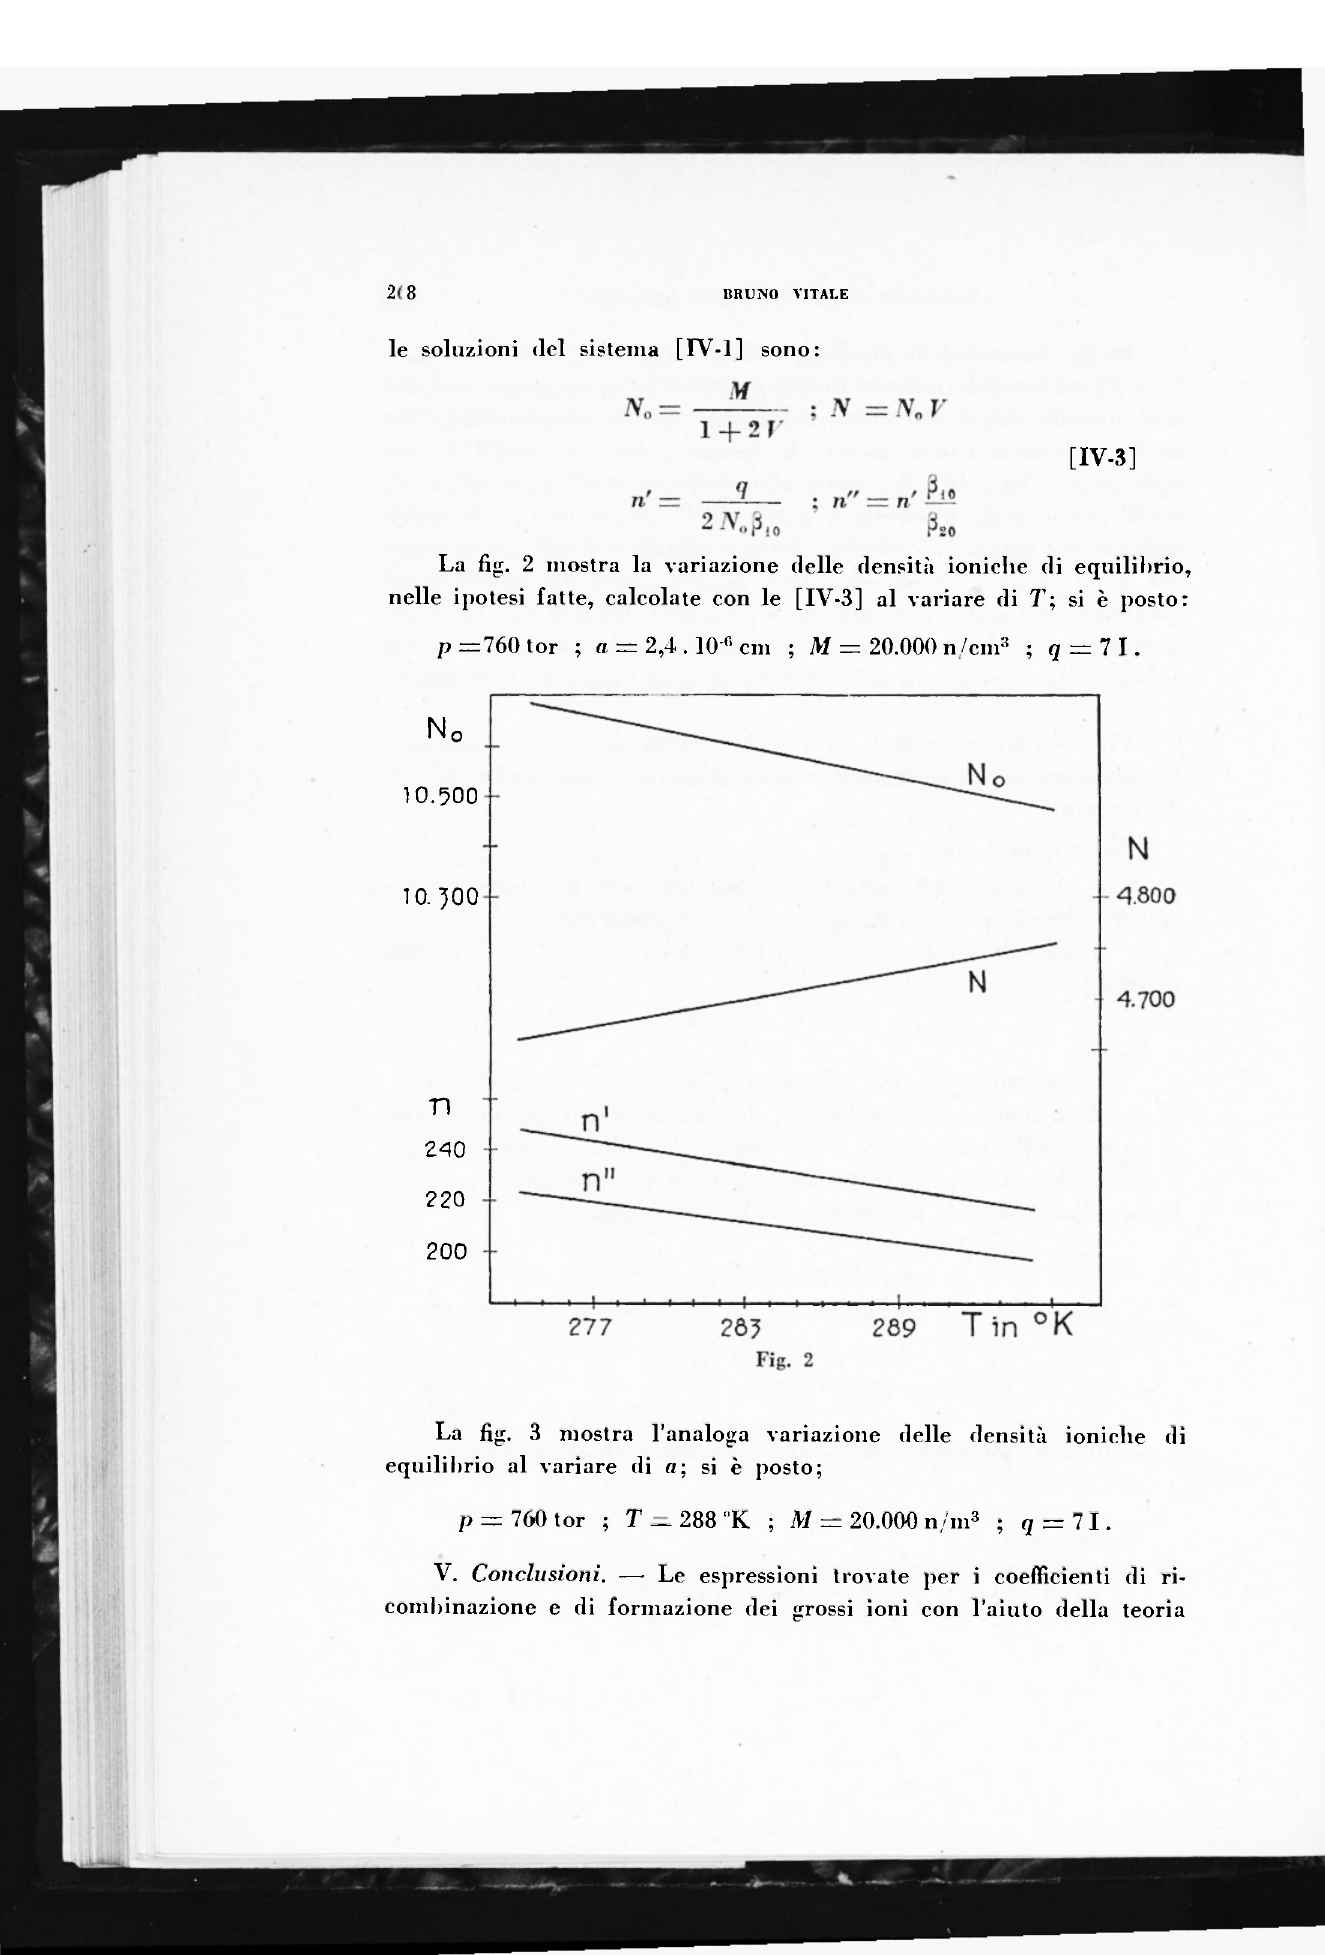
La fig. 3 mostra l'analoga variazione delle densità ioniche di equilibrio al variare di a; si è